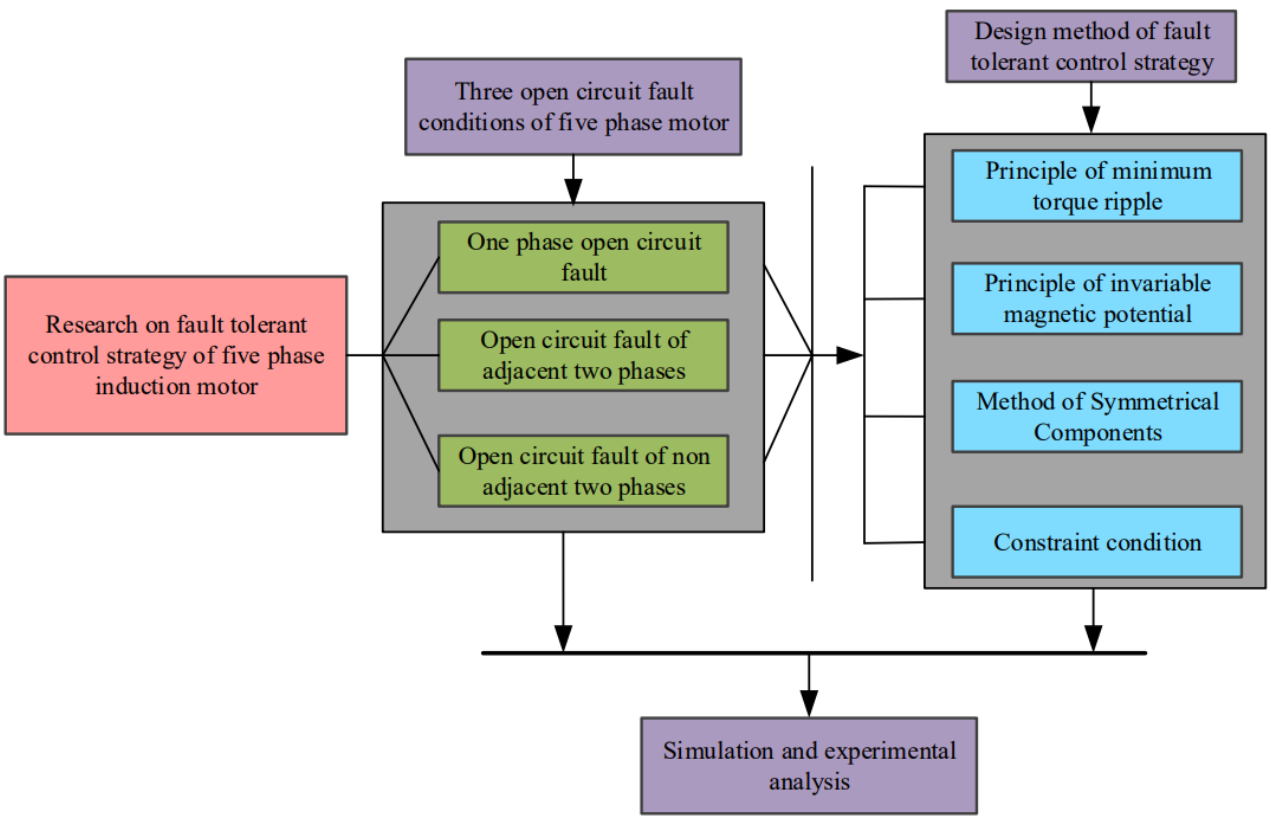
Figure 1. Summary of main research contents and methods in this paper.